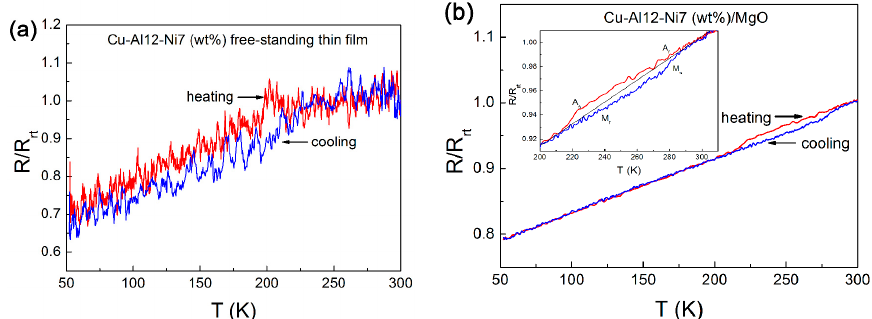
Figure 5. Resistance vs. temperature measurement of Cu–12Al–7Ni (wt.%) films prepared by ( a ) heat treatment after sputtering and ( b ) in situ heating during growth.